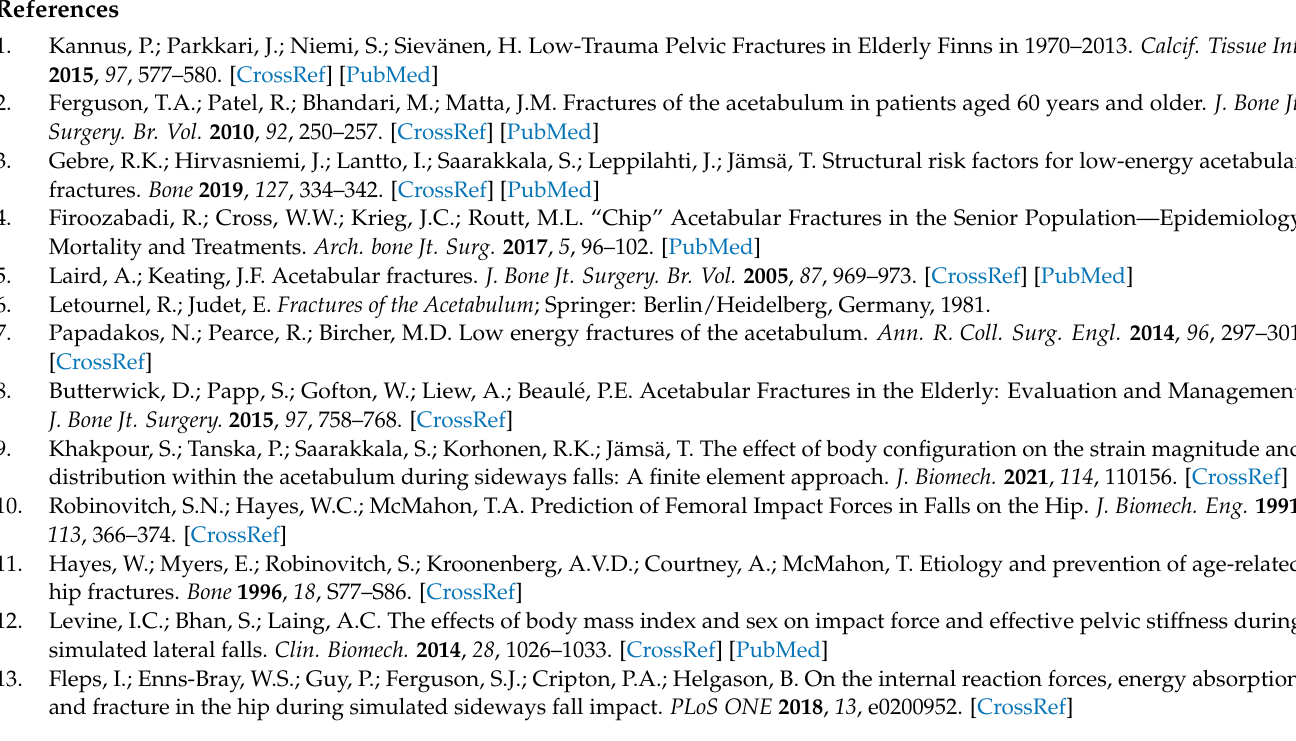
Figure A8. Internal reaction force history graphs within the joints for the trochanteric soft tissue model proposed by Majumder et al. [32] and Fleps et al. [13].